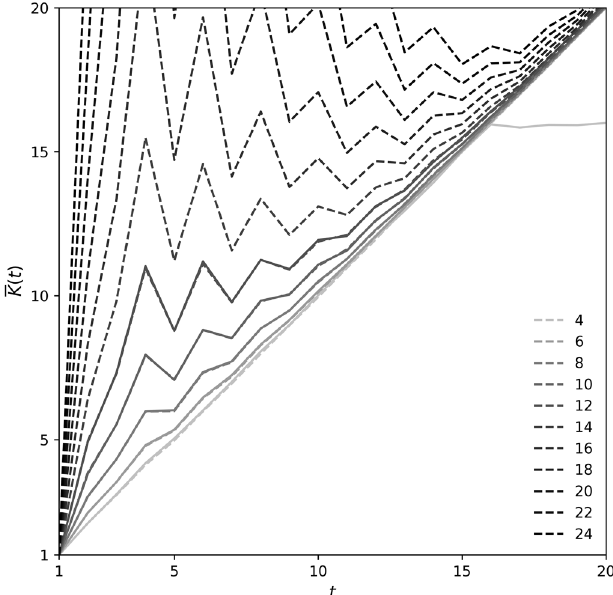
¯ K ð t Þ with periodic H